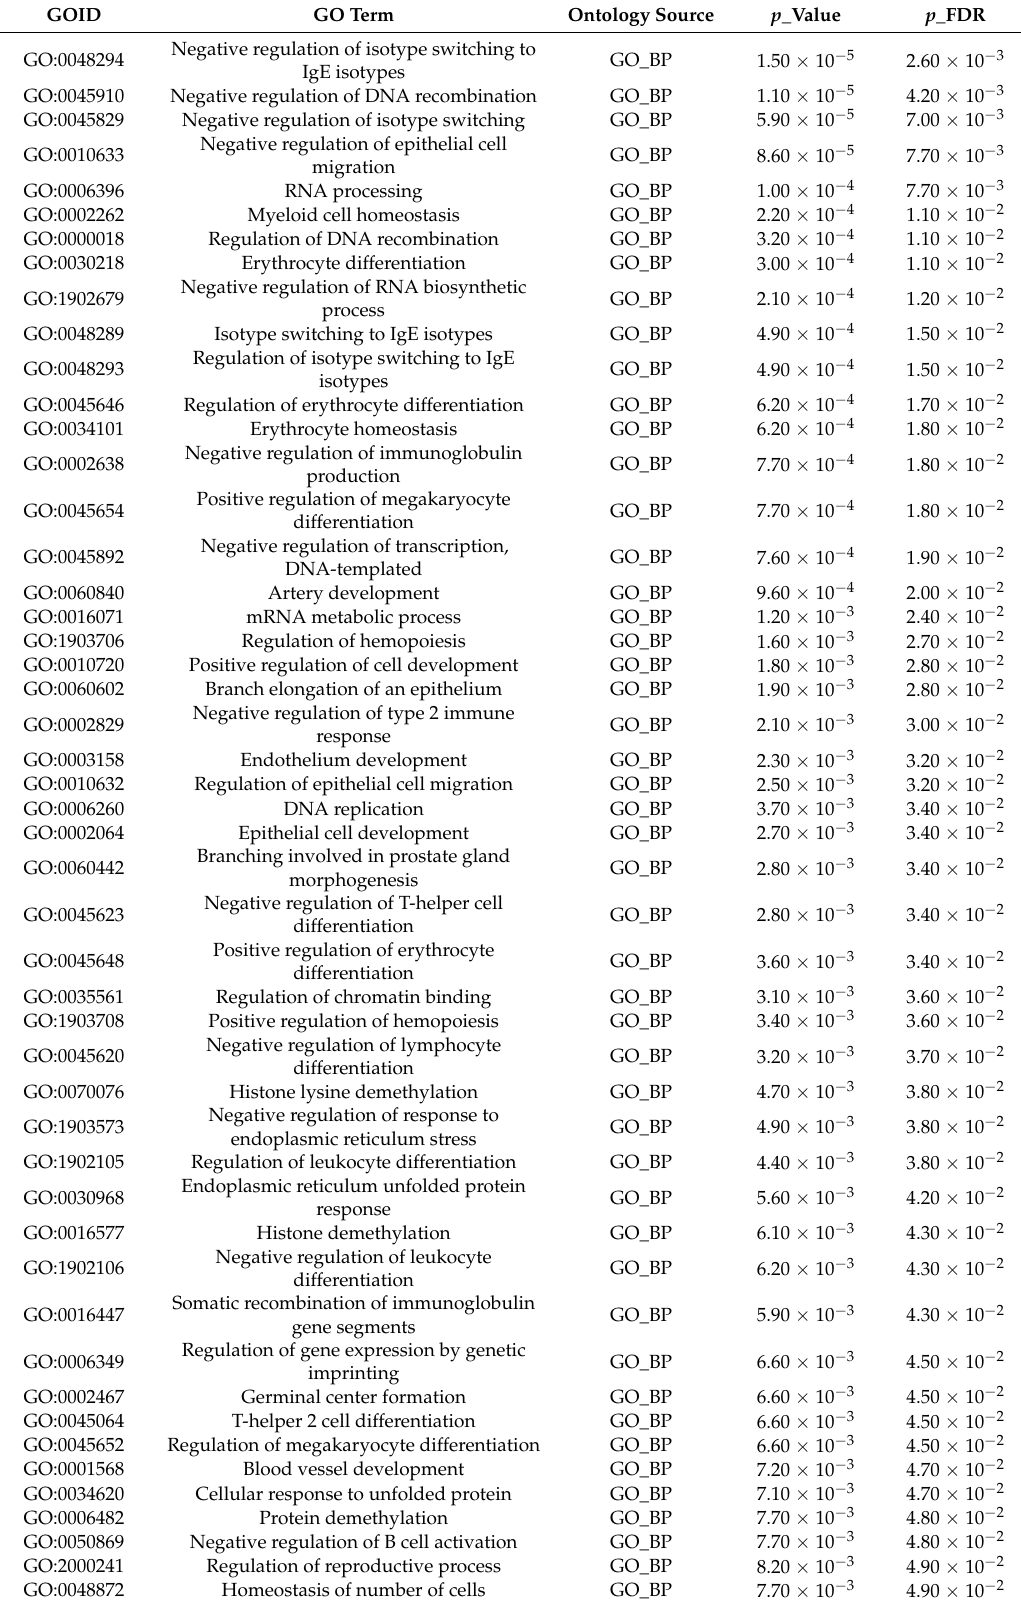
Table 2. Gene ontologies enriched for cis target genes of lncRNAs in SFO